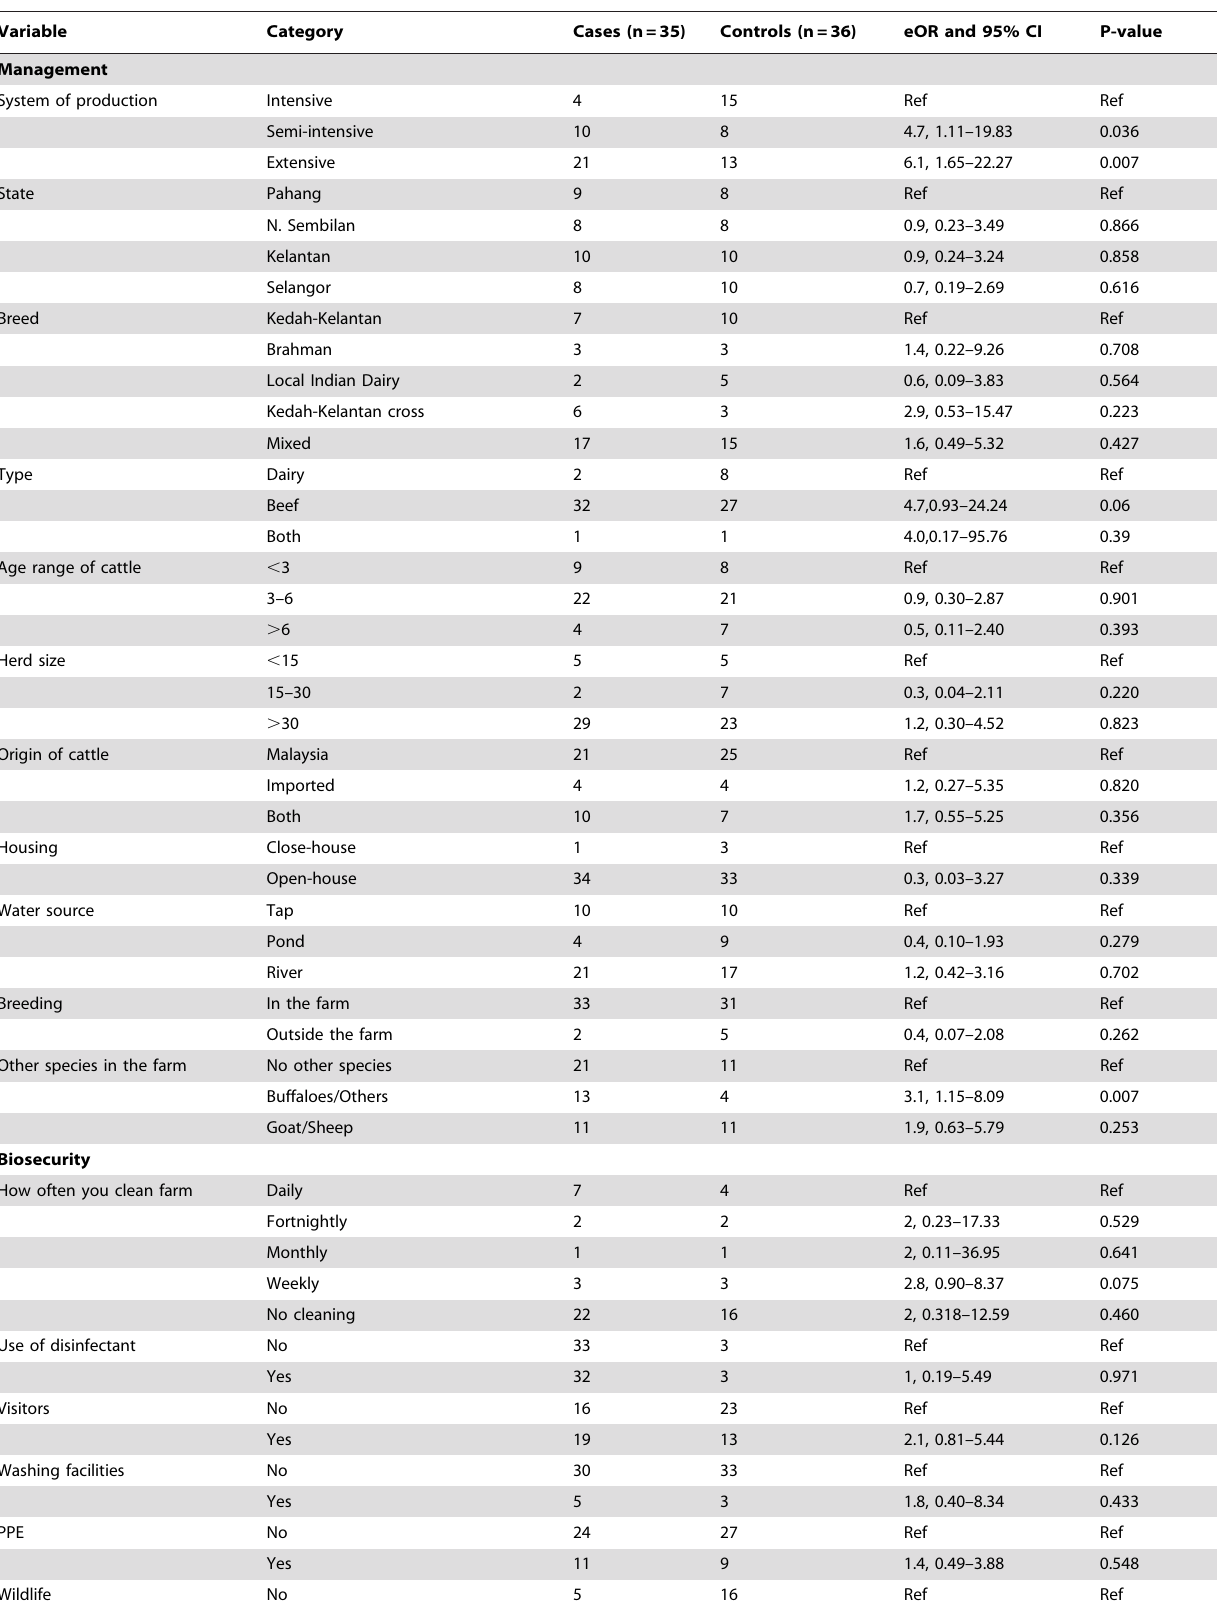
Table 1. Univariable analysis of potential risk factors for bovine brucellosis herd seropositivity in Peninsular Malaysia.